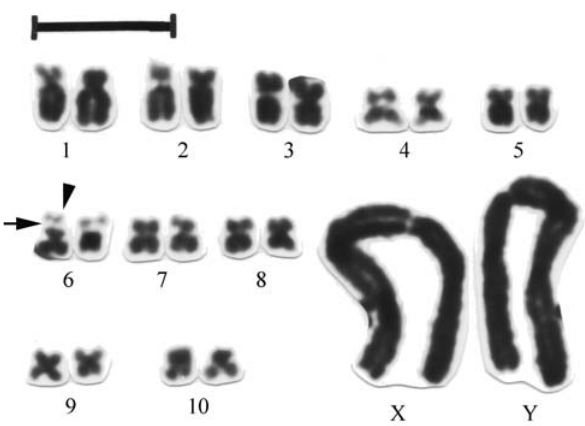
Figure 2 - Giemsa-stained Paranaita opima male embryo with 2n = 22 (20+XY) karyotype. Note the secondary constriction (arrow) and the neg- ative heteropycnosis (arrowhead) on pair 6 and the extremely large sex chromosomes. Bar = 10 (cid:2) m.